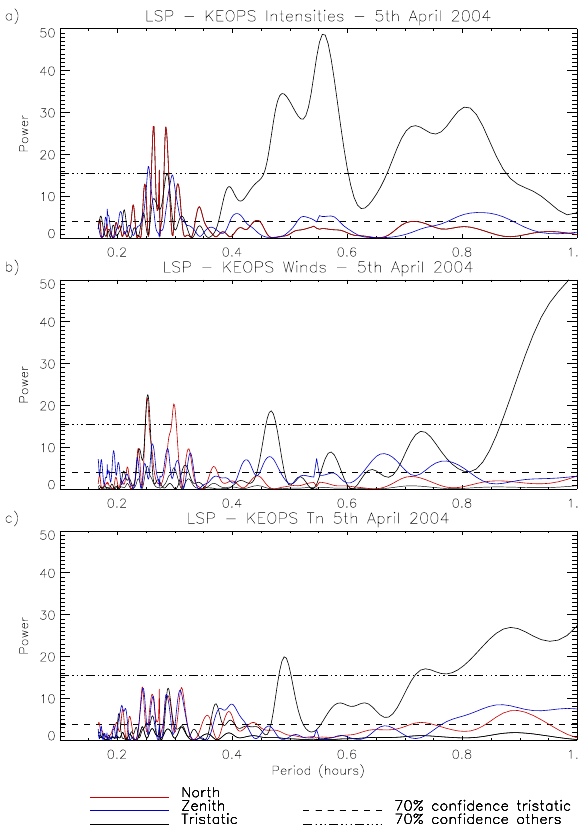
Fig. 9. Lomb-Scargle Periodogram up to periods of 1h, from KEOPS data on 5 April 2004: (a) intensities, (b) winds, and (c) temperatures. The low resolution look directions are scaled by a factor of